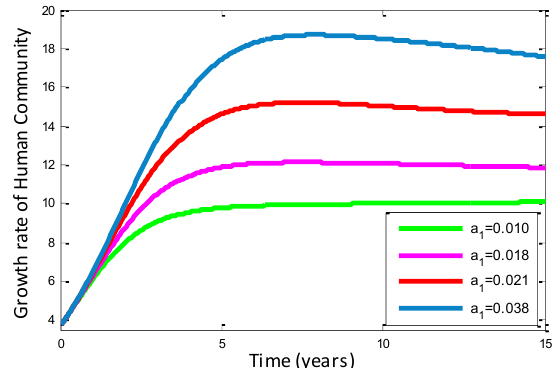
Figure 9 . The growth rate of human communities at different values of 1 a